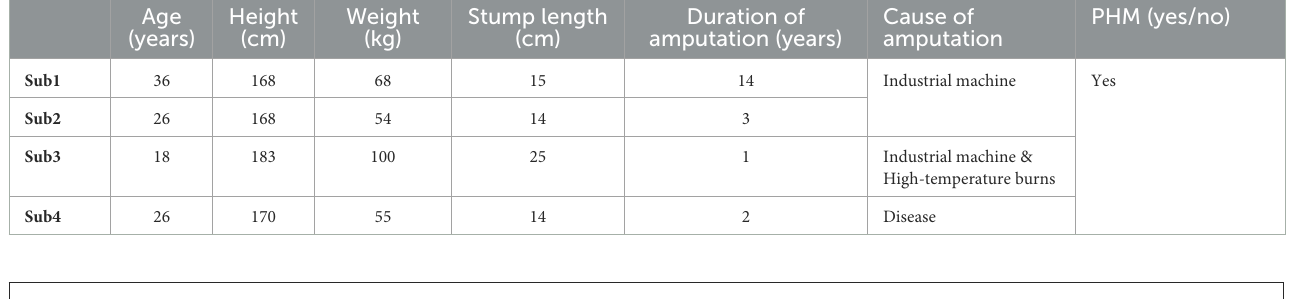
TABLE 1 Information about subjects.